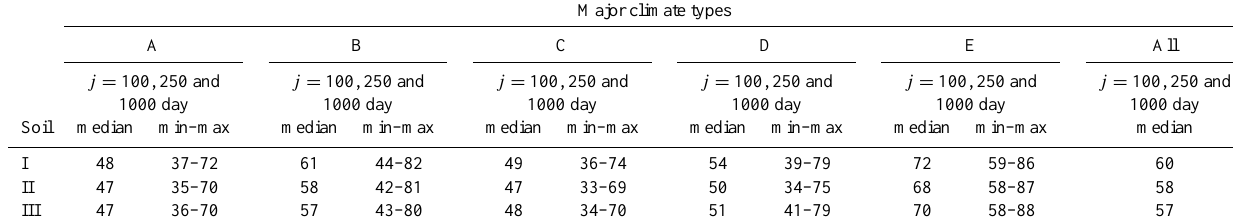
Table 5. Impact of groundwater systems on the similarity index (SI) (%) for five K¨oppen–Geiger major climate types and three soils. Major climate